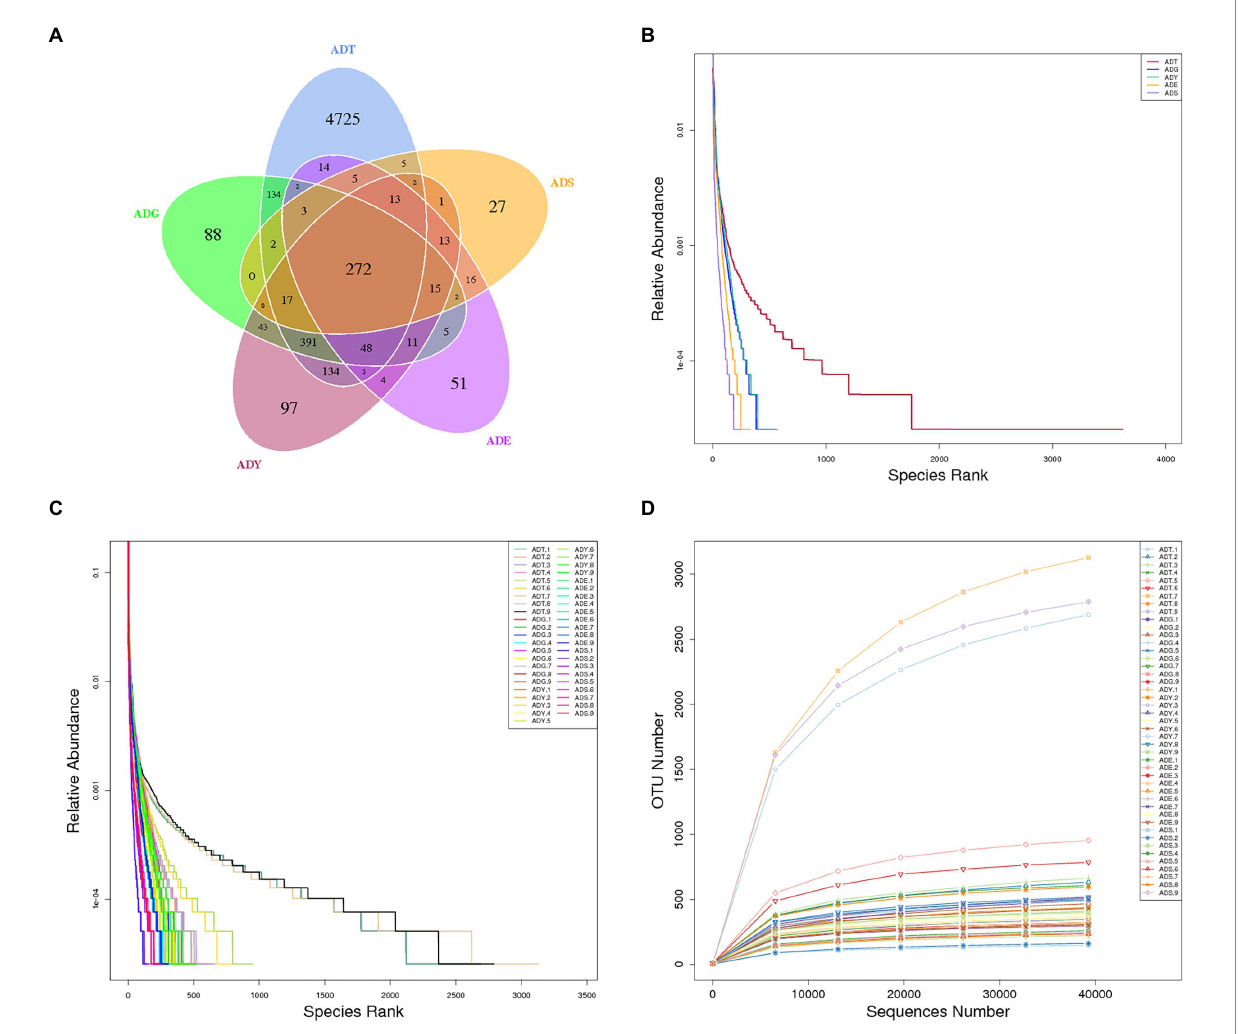
FIGURE 4 Venn diagrams and feasibility analysis. (A) Venn diagrams of the distribution of OTUs in five groups. (B) Rank abundance curves for groups. (C) Rank abundance curves for samples. (D) Rarefaction curves for samples.